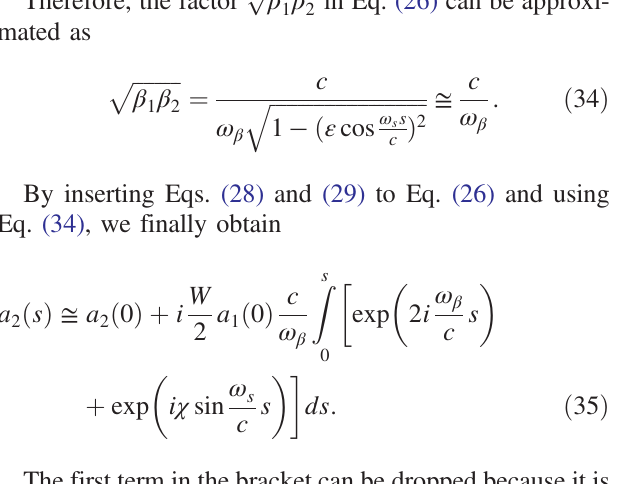
FIG. 1. The complex function f ð χ Þ as a function of χ . The real and the imaginary parts of f ð χ Þ , namely, h ð χ Þ and g ð χ Þ , are denoted by the blue solid and the blue dashed lines,